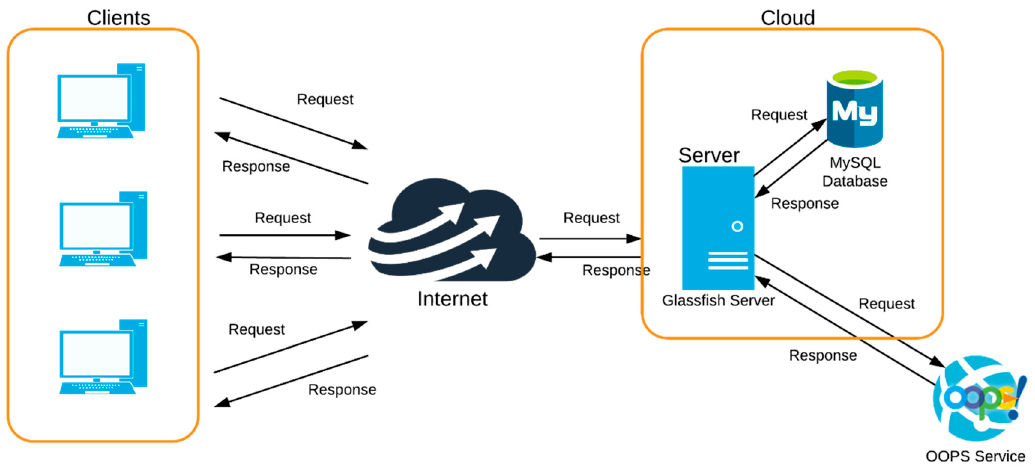
Figure 2. Application architecture.